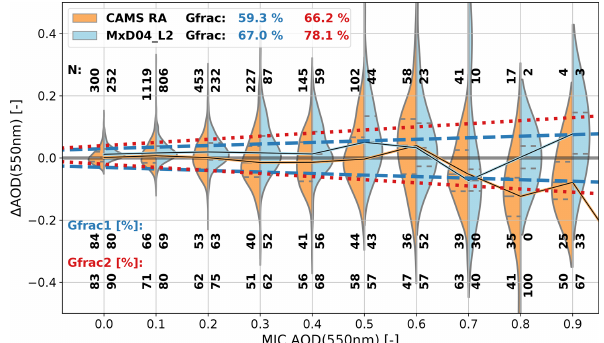
Figure 10. Same as Fig. 4 but comparing CAMS RA and MODIS MxD04_L2 AOD to MIC AOD as